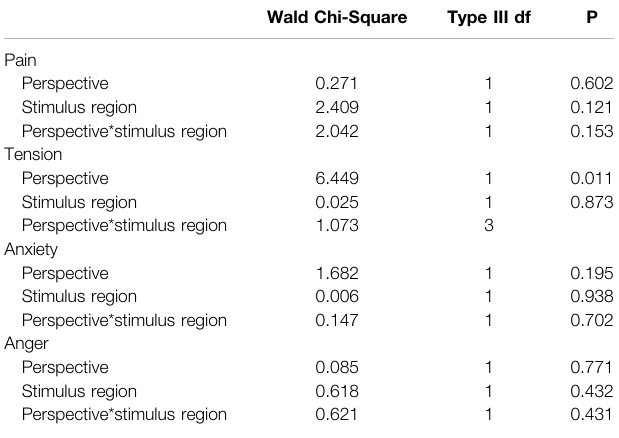
TABLE 2 | Results of ordinal logistic generalized estimating equation for verbal Likert Scale data.